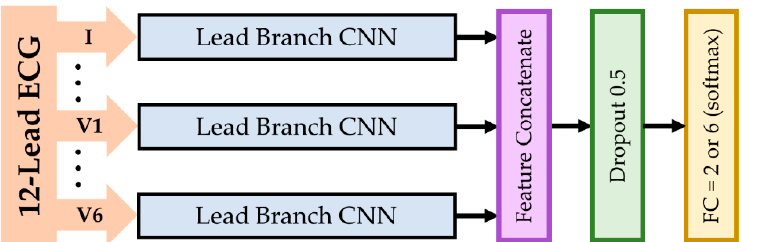
Figure 5. Multi-lead features-concatenate network. Twelve (12) lead branch convolutional neural networks (CNNs) were used to extract features in each lead independently and were then concatenated and classified.